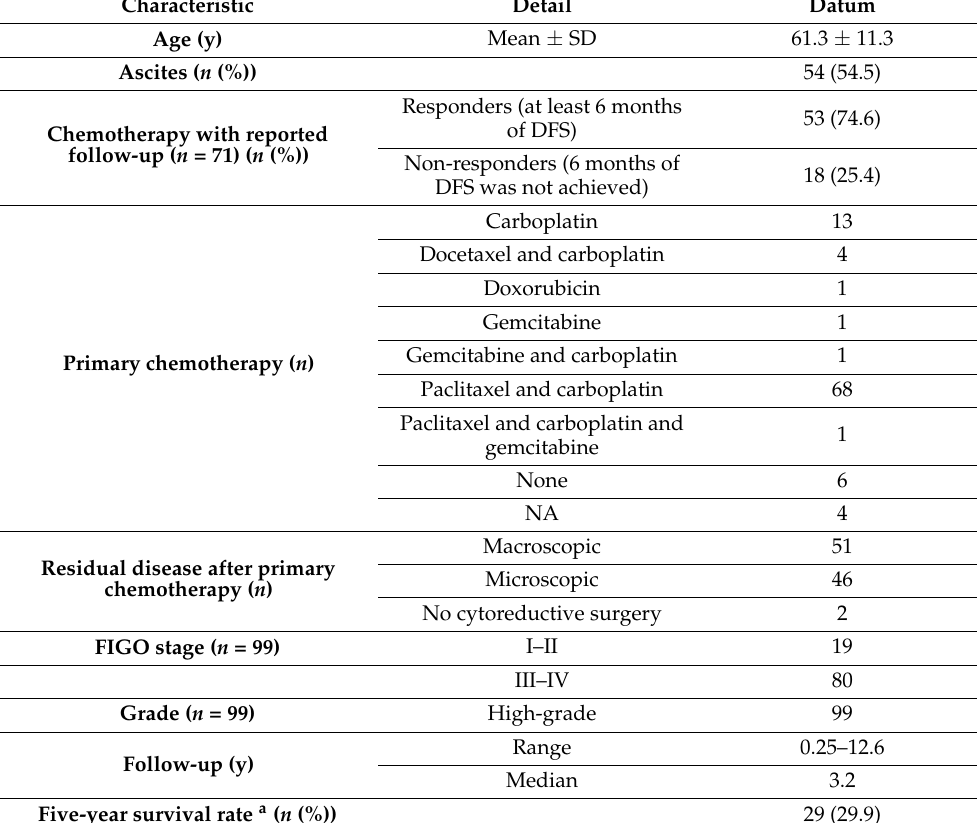
Table 1. Clinical and histopathological data of HGSC